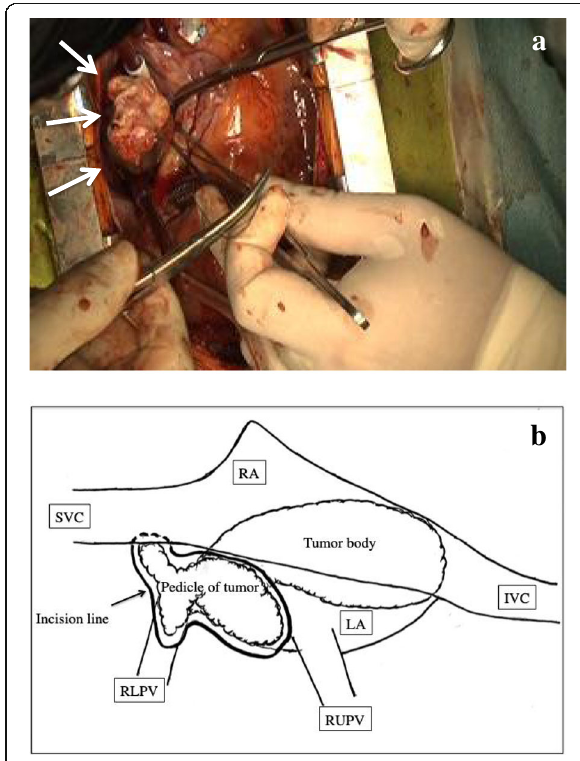
Fig. 2 Intraoperative view. A tumor was extirpated through an incision in the right side of the LA wall (white arrows) ( a ). A schema of the existence of the tumor in the LA. The tumor pedicle was widely and irregularly attached to the LA wall, which extended to the right upper pulmonary vein, and the tumor body was bound for mitral annulus ( b